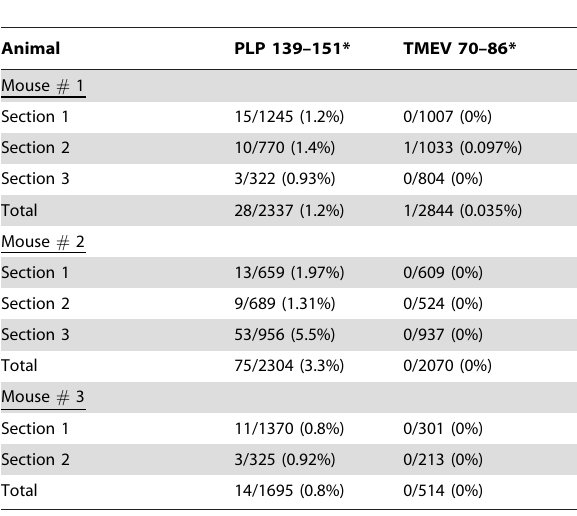
Table 2. Quantitative analysis of Myhc 334–352 dext + CD4 + T cells in the hearts of EAM mice by confocal